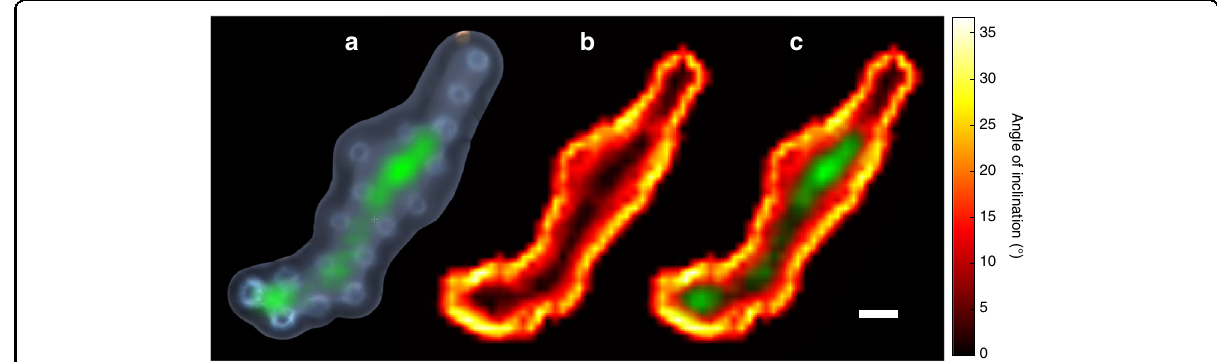
Fig. 5 Spatially resolved Brillouin spectroscopy with a fi bre probe. The mean Brillouin frequency for the structure in Fig. 4a was measured as f B (PS) = 8.43 ± 0.17 GHz; a spectral amplitude map at f B (PS) overlaid onto the bright fi eld image. b Surface gradient (degrees inclination) revealing the steep edges of the object. Given the refractive index contrast (optical and acoustic) between water and PS, f B (PS) measurements are possible when the surface gradient of the object varies by less than 10°. c This is con fi rmed by overlaying the amplitude map ( a ) onto the surface gradient map ( b ), where high amplitude corresponds with fl atness. The object Brillouin frequency is unresolved for the shortest region of the phantom due to attenuation. Scale bar: 10 μ